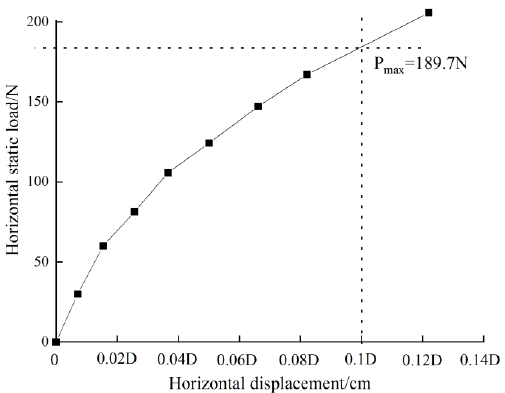
Figure 6. Horizontal static load curve.